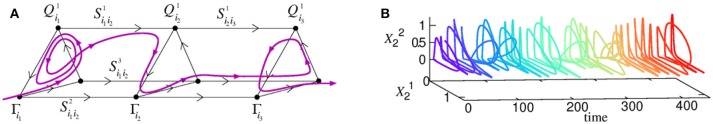
(A) An illustration of a 3-modality heteroclinic network and one of the associated trajectories in its vicinity corresponding to the binding process. (B) Joint dynamics of two temporally coordinated binded modalities (Rabinovich et al., 2010a). The time series is plotted with a color-code representing the evolution of time to favor the visualization.